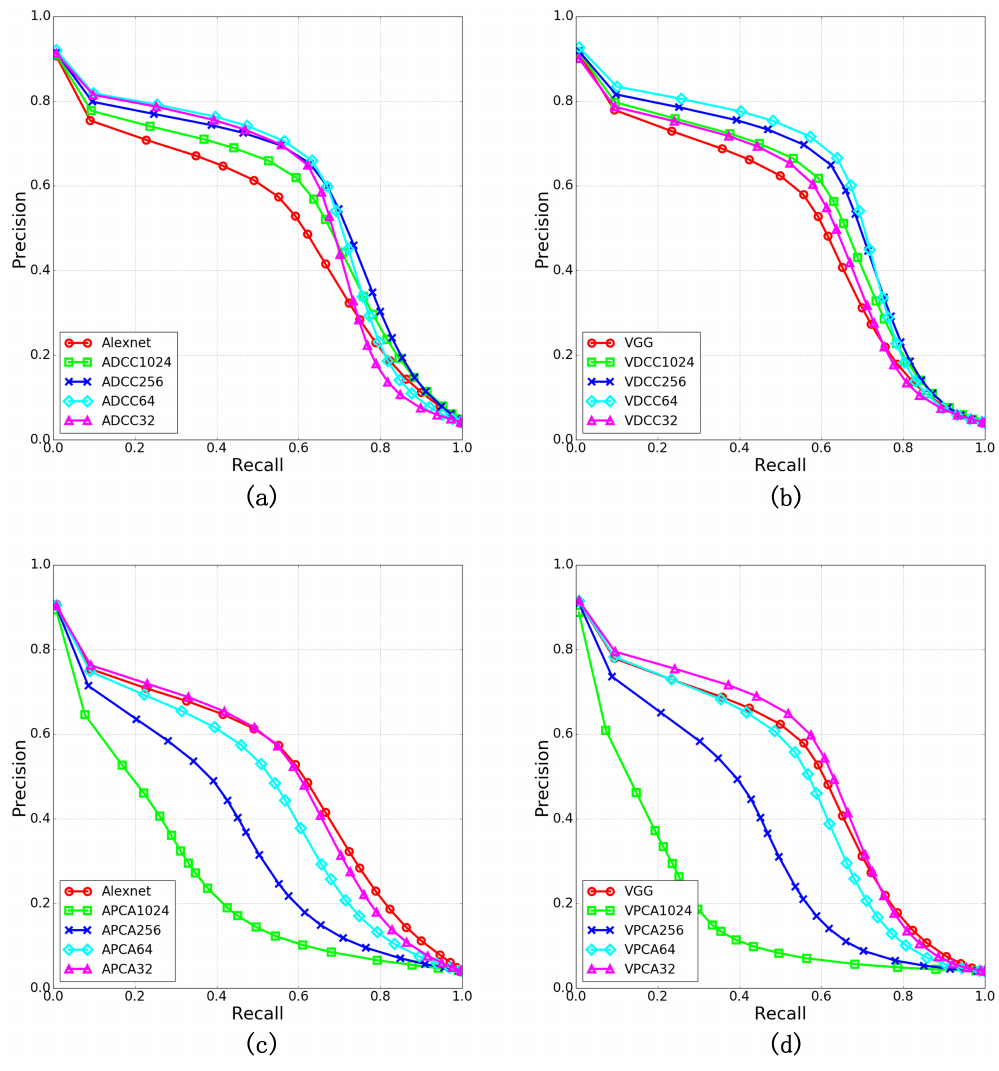
Figure 4. Recall-precision curves for the different methods. ( a ) DCC method based on Alexnet; ( b ) DCC method based on VGG; ( c ) DPCA method based on Alexnet; and ( d ) DPCA method based on